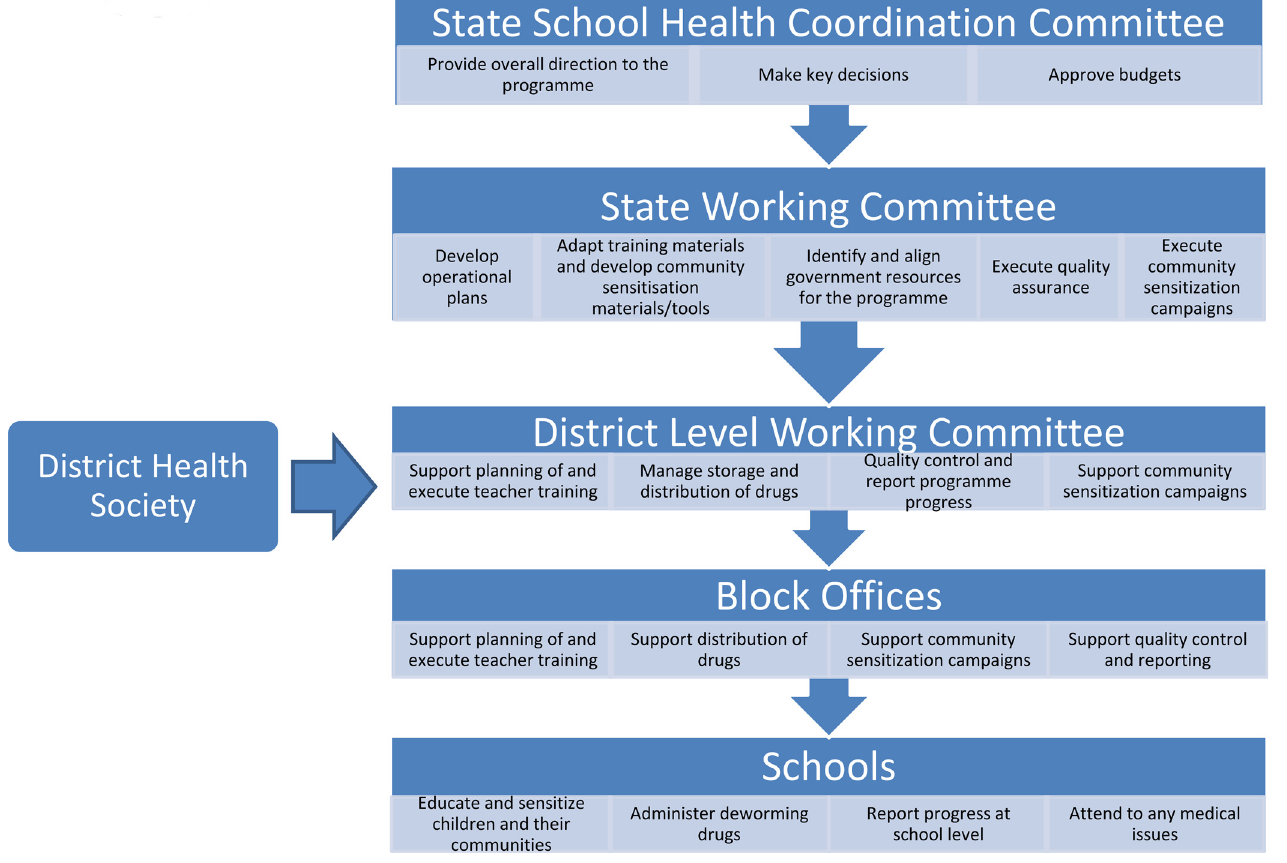
Fig 1. Structure of the state government ministries and offices and respective roles in the deworming programme in Bihar state. Leveraging of the existing state government structures was critical for the successful rollout of large-scale operations, including drug procurement and delivery, training, community sensitization, and